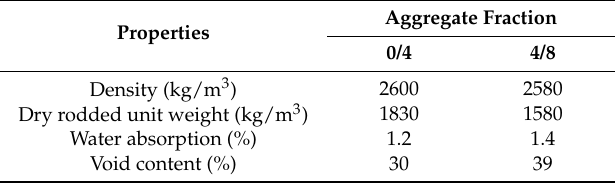
Table 1. Properties of aggregate used in experimental